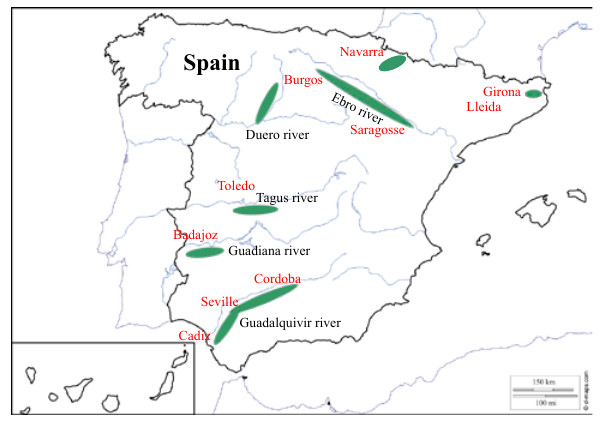
Figure 1. Main wheat growing regions (green) and provinces (red font) in Spain, that are prone to rust